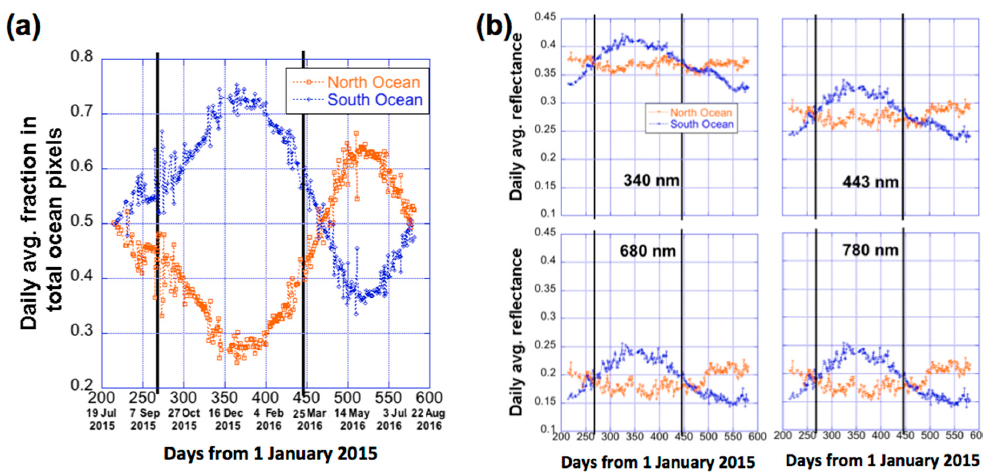
Figure 5. Time-series of ( a ) daily average fraction of northern and southern oceans within the total sunlit oceans and ( b ) daily average reflectance over northern (orange) and southern (blue) oceans from July 2015 to August 2016. The two vertical black lines represent the two equinox dates of 23 September 2015 and 20 March 2016. Why are the patterns of southern and northern oceans so different? Assuming that in all ocean regions reflection from surface and scattering from air molecules and aerosols are relatively uniform both spatially and temporally, the difference in patterns most likely comes from different cloud contributions over the northern and southern oceans. To this end, we recall the results of King et al. [18] on the seasonal variations of cloud spatial distributions based on more than 12 years of MODIS data. MODIS’s results indicate that cloud properties (e.g., cloud fraction and optical thickness) are different for different latitudes and seasons.